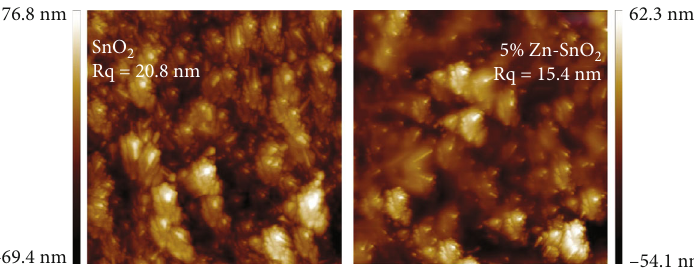
fi lms with and without Zn doping. 2